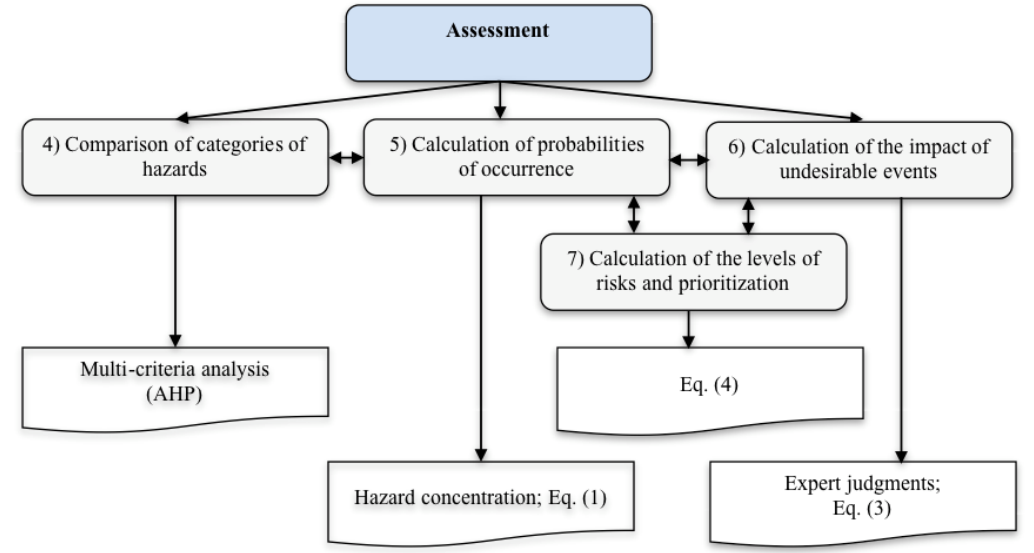
Figure 4. Assessment phase of the risk-factors-based